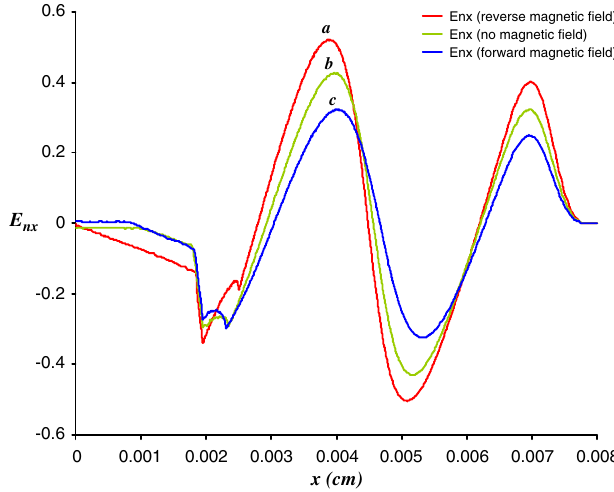
FIG. 4. Variation of normalized longitudinal electrostatic Þ with k (cid:5) for (cid:1) ¼(cid:4) 1 (curve a ), (cid:1) ¼ 0 (curve b ), wakefield ð E nz p ¼ 32 (cid:9) m , and L ¼ 7 : 2 (cid:9) m . and (cid:1) ¼þ 1 (curve c ) for a 0 ¼ 0 : 3 , (cid:8) p Curve d shows the evolution of the laser pulse.